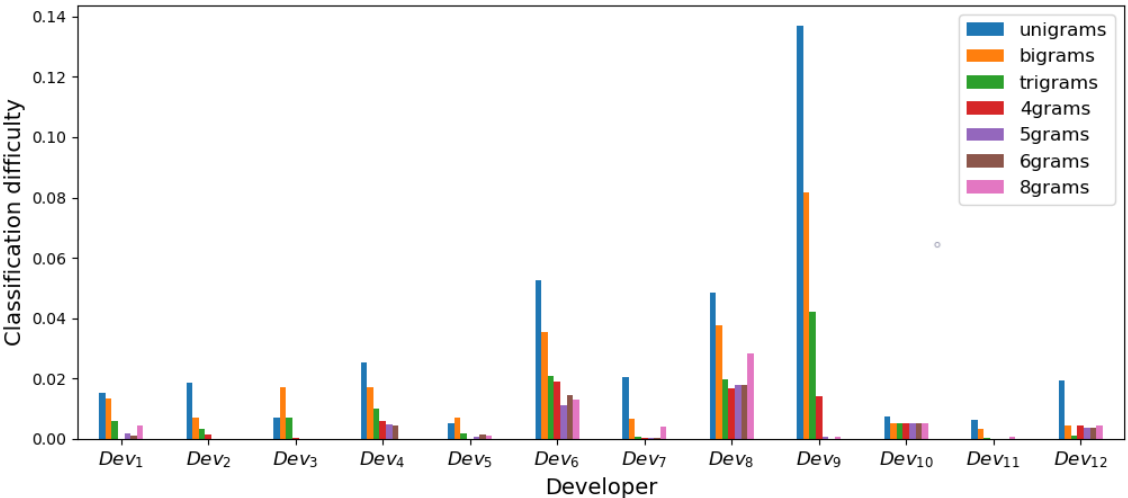
Figure 4. Classification difficulty for 12 developers with respect to N -gram size for doc2vec vector size of 300.